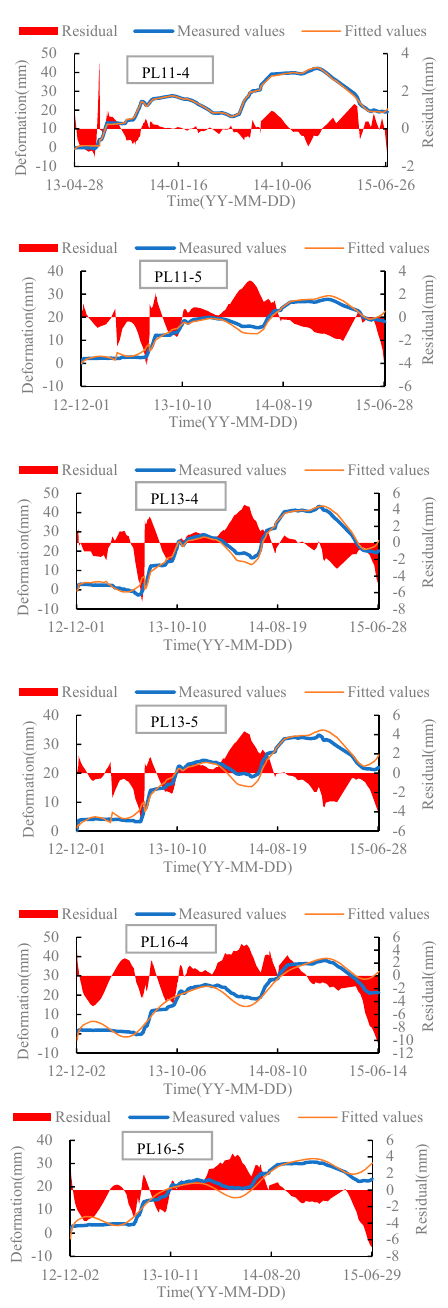
Figure 12. Measurement points fitting and residual diagram. Table 5. Model accuracy of representative key monitoring positions.